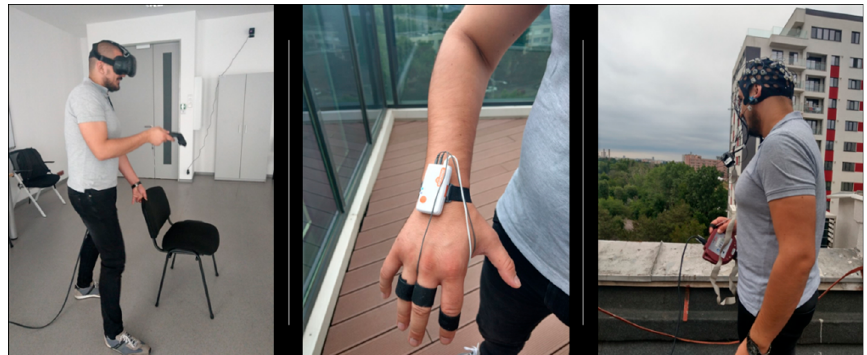
Figure 2. User during in vivo and virtual exposure with physiological signals